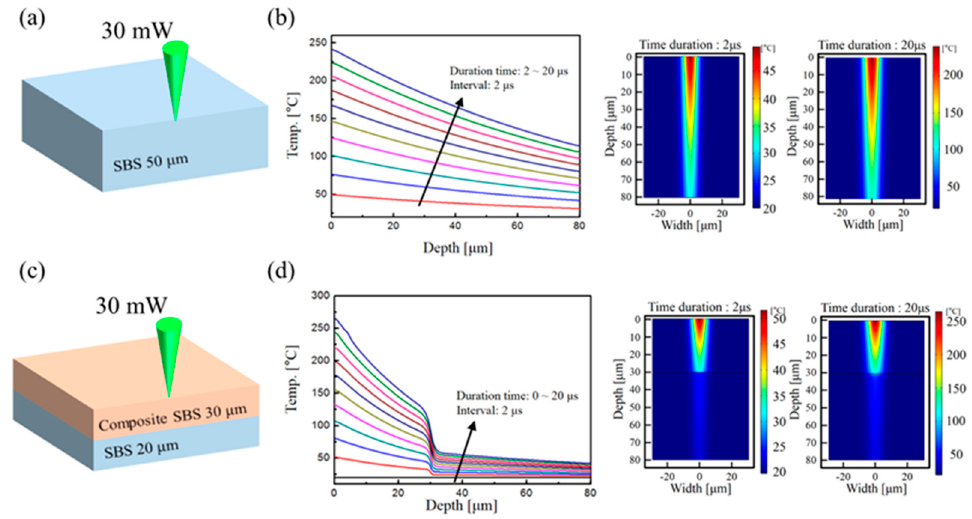
Figure 3. Schematics of simulation model of SBS ( a ) and composite SBS and SBS ( c ). Plot of the temperature change in depth (left) after laser irradiation from 0 µ s to 20 µ s (interval of 2 µ s) and the temperature distribution in the vertical section of the substrate (right) after laser irradiation at 2 µ s and 20 µ s on the SBS ( b ) and composite SBS and SBS ( d ), respectively.